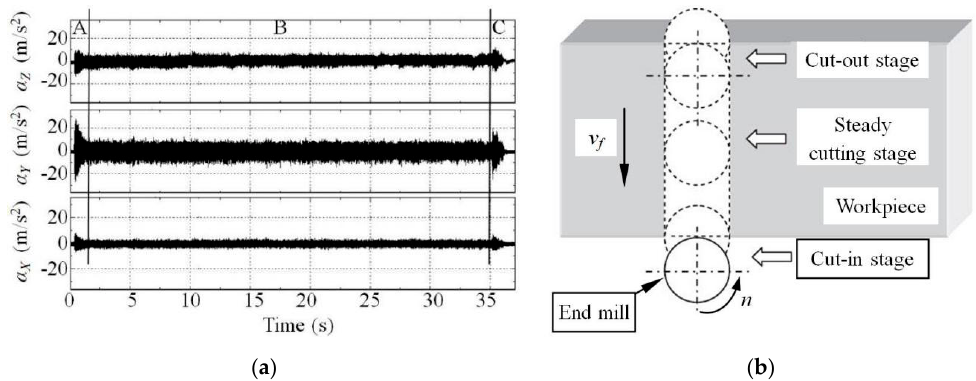
Figure 2. ( a ) Time–domain waveform of cutting vibration. ( b ) three stages of milling straight groove.